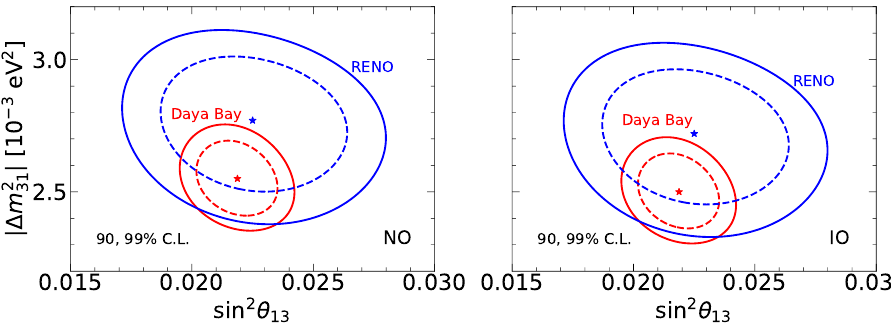
Figure 2 . 90 and 99% C.L. (2 d.o.f.) allowed regions in the sin 2 θ 13 – ∆ m 2 and Daya Bay (red). The best fit values are indicated by stars. The left (right) panels correspond to NO